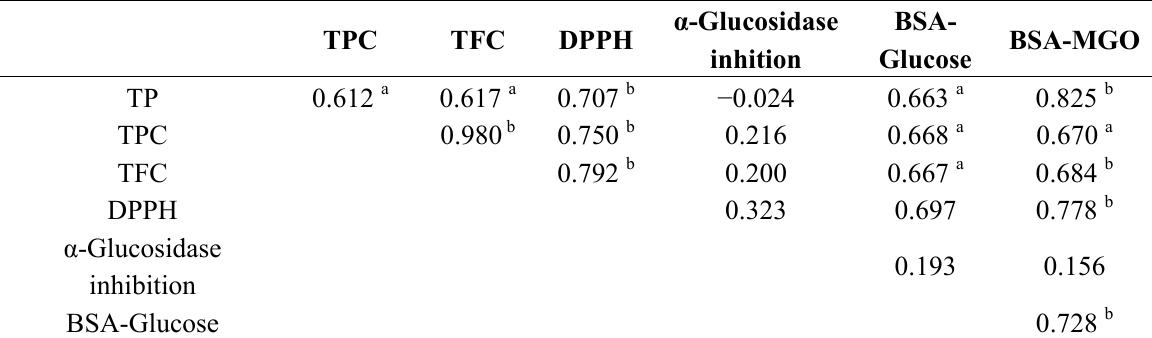
Table 4. Correlation coefficient of total phenolics acid, DPPH, α -glucosidase inhibition, BSA-MGO, BSA-Glucose and tyrosinase inhibition